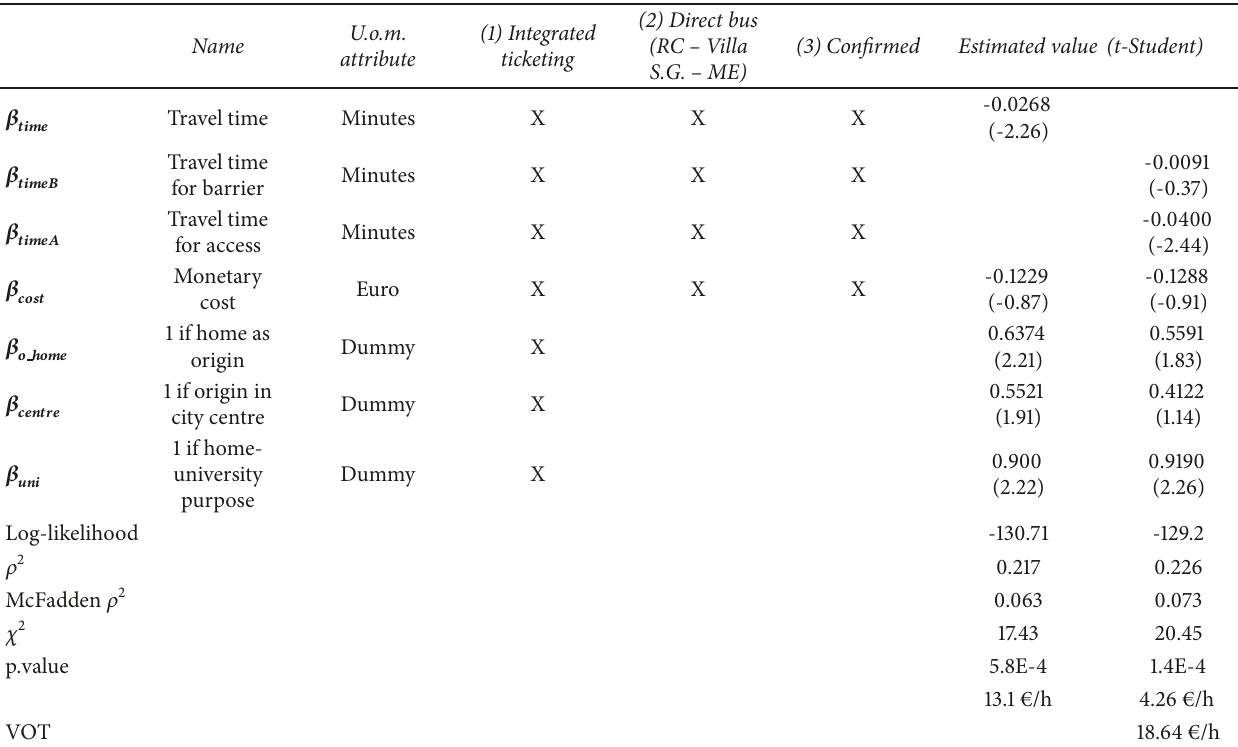
Table 2: Calibrated SP